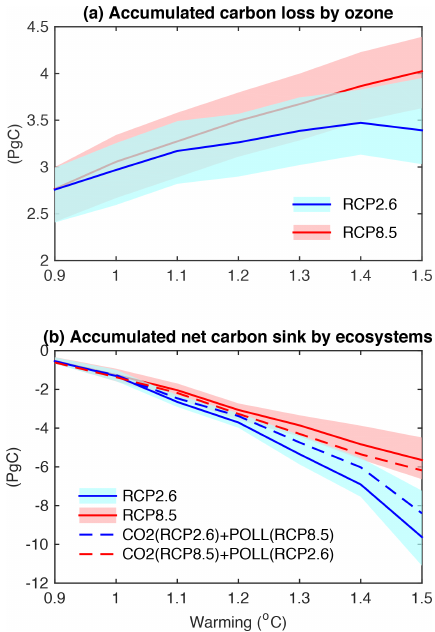
Figure 8. Accumulated carbon budget in China under 1.5 ◦ C global warming. (a) shows the total carbon loss of ecosystems caused by O 3 damaging effects at different warming thresholds for two emission pathways. The bottom panel shows the accumulated net carbon sink by ecosystems in China at the 1.5 ◦ C global warm- ing. The two solid lines represent emissions of CO 2 and pollu- tants from the same scenario, either RCP2.6 (blue) or RCP8.5 (red). The dashed lines represent sensitivity experiments with inconsistent CO 2 and pollutants, with the blue (red) line driven with CO 2 from RCP2.6 (RCP8.5) but air pollution from RCP8.5 (RCP2.6). The warming of 1.0 ◦ C is the year 2010 for both RCP2.6 and RCP8.5